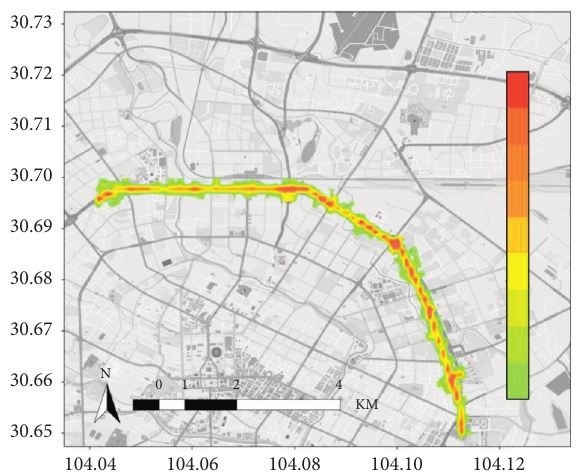
Figure 22: Safety assessment of second ring expressway in Chengdu Vehicle conflict risk points and risk levels are shown in Figure 21.